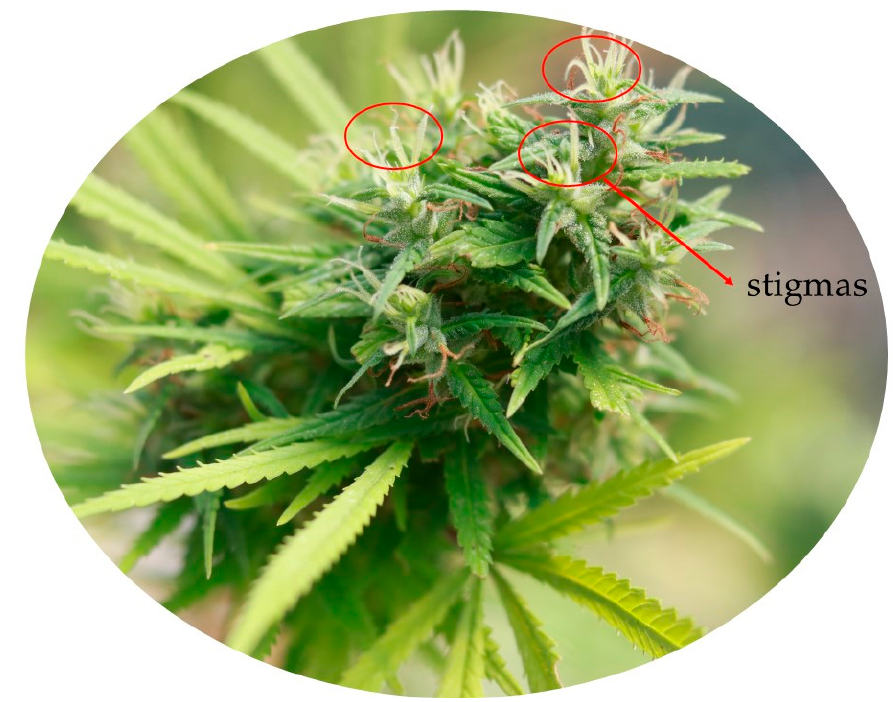
Figure 1. Cannabis inflorescence with emphasis on